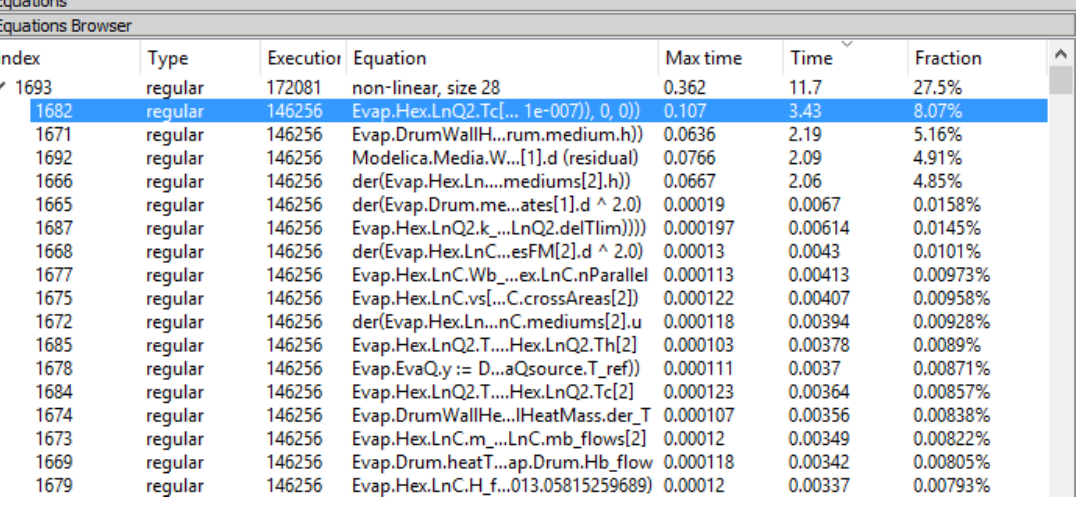
Figure 13: Transformational debugger and pro(cid:28)ling